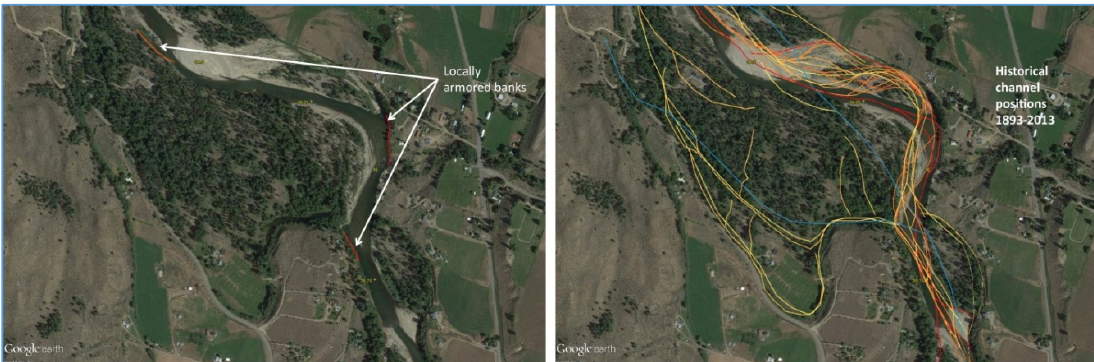
Figure 6. Example of bank armoring that locally precludes maintenance of active channel-migration processes along the Twisp to Carlton reach of the Methow River. Flow is from the upper left to the bottom right of the images; base imagery from Google Earth. Left panel: red lines indicate field-mapped extent of bank armoring; numbers along the channel are river miles. Right panel: air photo-mapped channel centerlines through this reach: blue = 1893, yellow = 1940s, orange = 1960s–1970s, red = 2004, air photo base = 2013. The extent of channel migration has been significantly reduced post-1940s, in large measure from bank armoring.